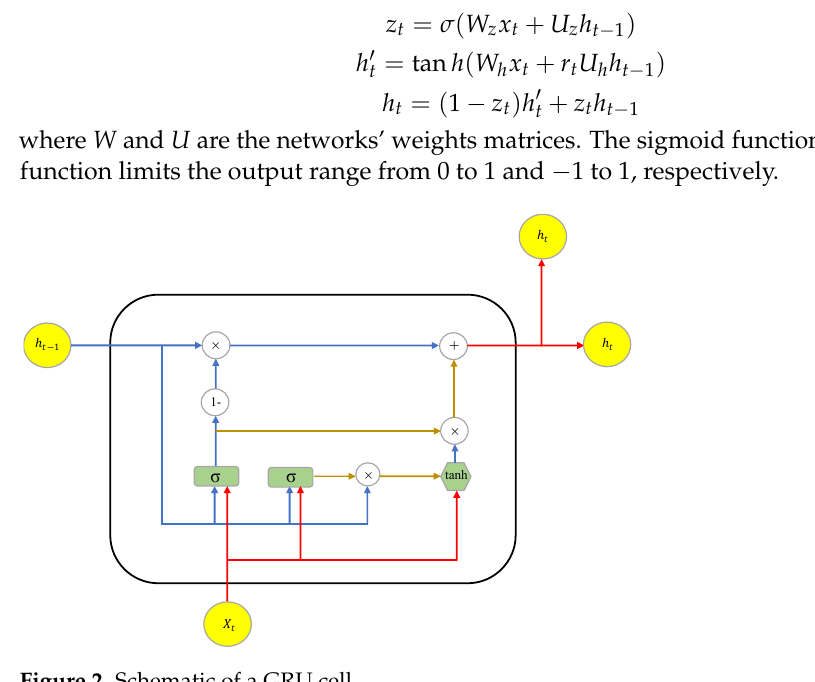
Figure 2. Schematic of a GRU cell.